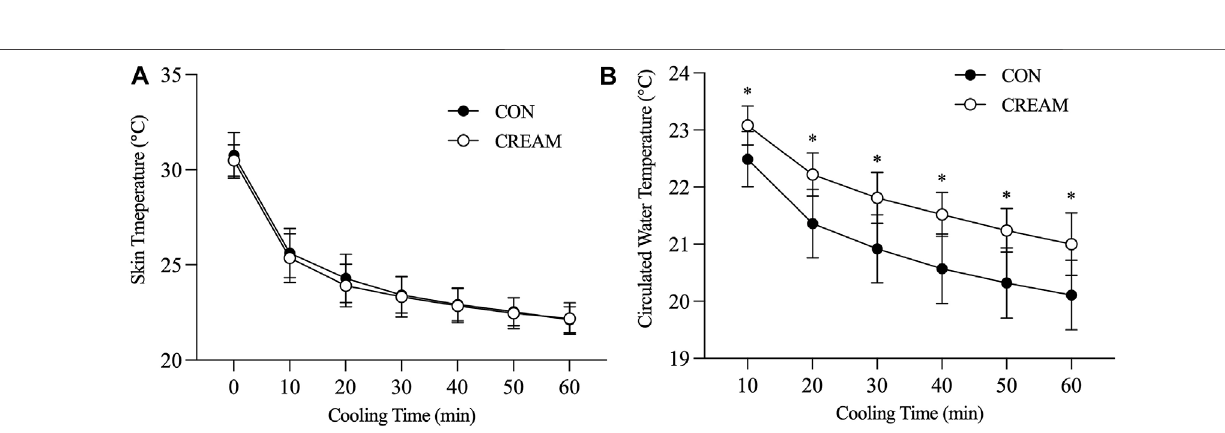
Frontiers in Physiology |